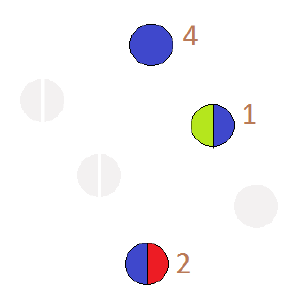
Figure A4. Representation of a node participating in more than one